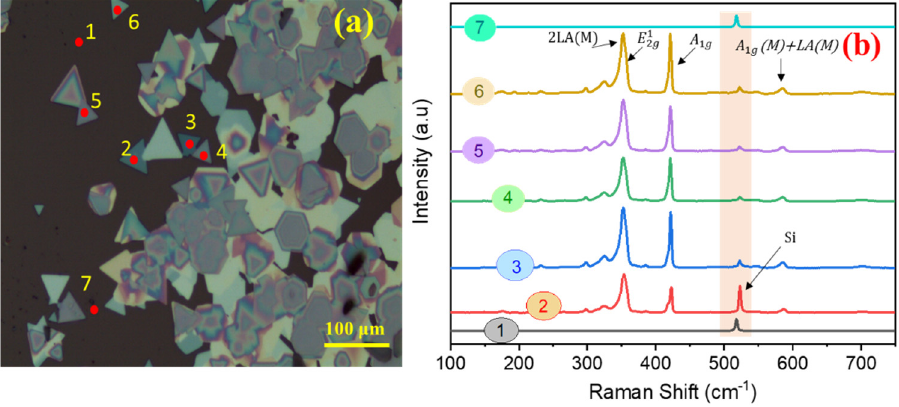
Figure 5. ( a ) Optical microscope image of WS 2 deposited over Si/SiO 2 , indicating the selected measurement spots, and ( b ) Raman spectra of the spots identified in ( a ) where peak at 520 cm − 1 in all the spectra is the LO mode of the silicon wafer.